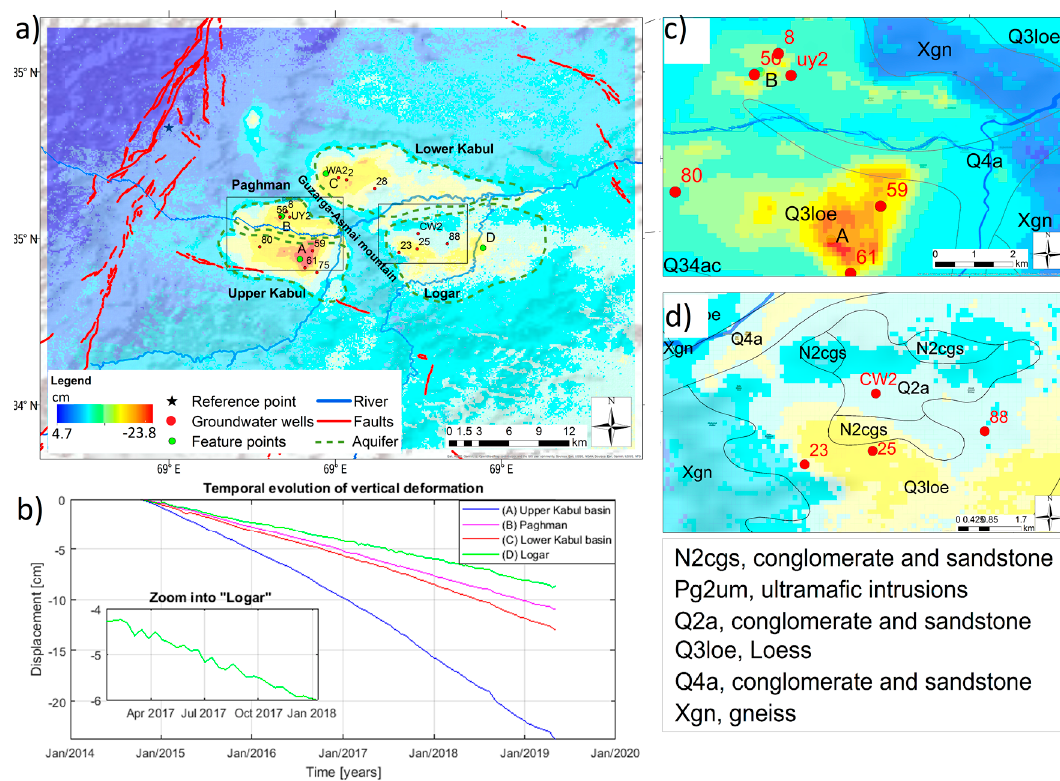
Figure 5. Spatial and temporal characteristics of subsidence: ( a ) Spatial distribution of subsidence bowls, displayed as cumulative vertical displacement (unit: cm). Red solid lines are mapped faults from [59]. ( b ) Temporal evolution of maximum vertical deformation at each of the four subsiding bowls. The inset plot illustrates small-scale deformation variations in Logar. ( c ) Magnified view of the Paghman river banks exhibiting a low- to non-deforming area. ( d ) Surface geological units map superimposed on deformation map, revealing the overlap of coarse-grained deposits with low subsidence values.